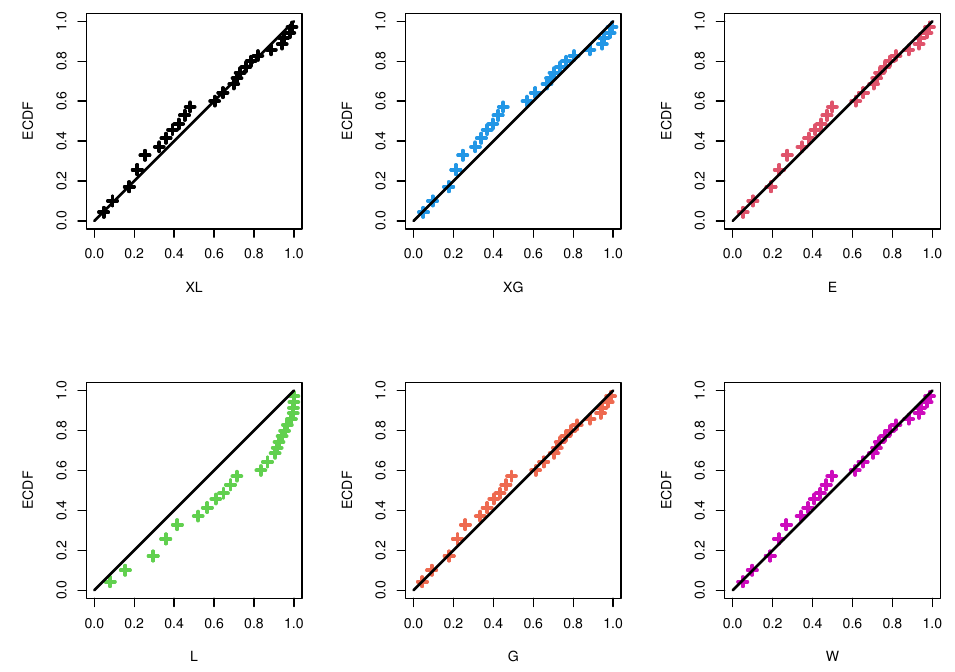
Figure 12. Fitted XL and competing models from vinyl chloride data. ( a ) PDFs. ( b ) RFs.